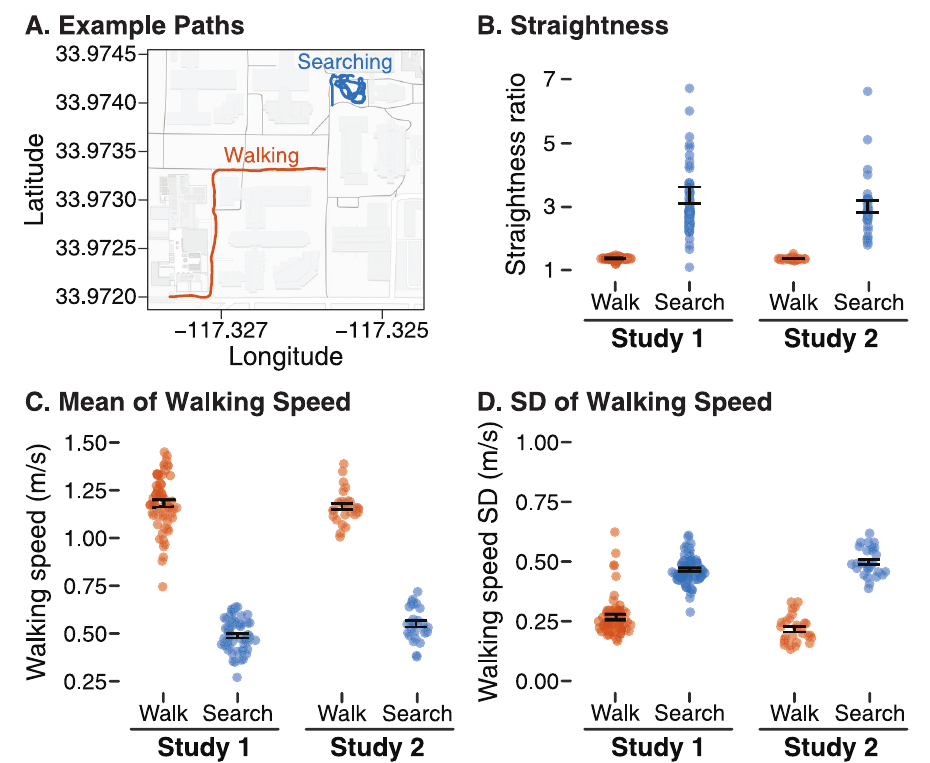
Fig 1. Characteristics of locomotion derived from GPS data in the walking and searching tasks (orange = walking task, blue = search and retrieval task). A) Example GPS recording of a participant’s path in the walking and searching tasks overlaid on a campus map. Graphs show differences in B) straightness ratio, C) mean walking speed, and D) SD of walking speed for Studies 1 and 2 according to task. Each symbol represents a single participant’s data; points are horizontally offset for visibility. Black error bars are centered on the mean and show ± 1 standard